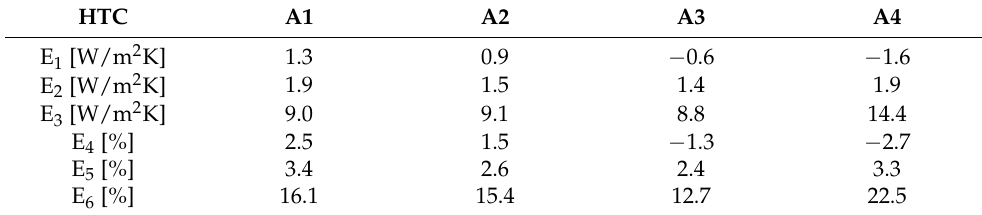
Table 11. Values of estimates E 1 –E 6 for HTC (20)–(25) with heating process p1 in planes